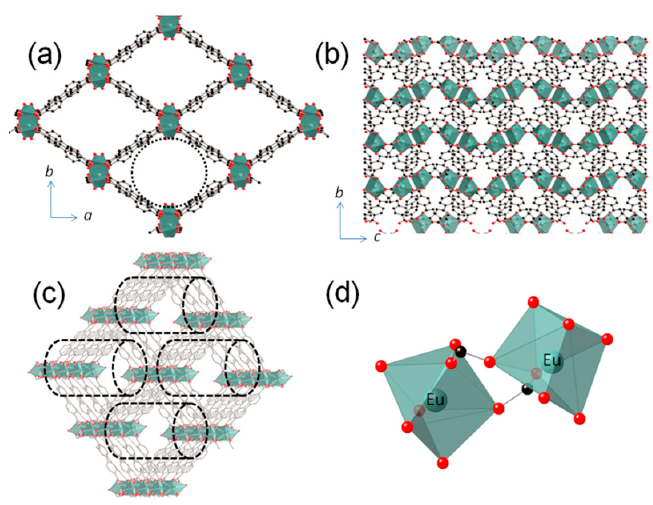
Figure 3. Projection on the ab and bc planes of Eu-BPDC ( a , b ), and the view of the nanochannels in the structure ( c ). The lanthanide environment of two adjacent metallic centers ( d ). Hydrogen atoms were omitted for clarity.